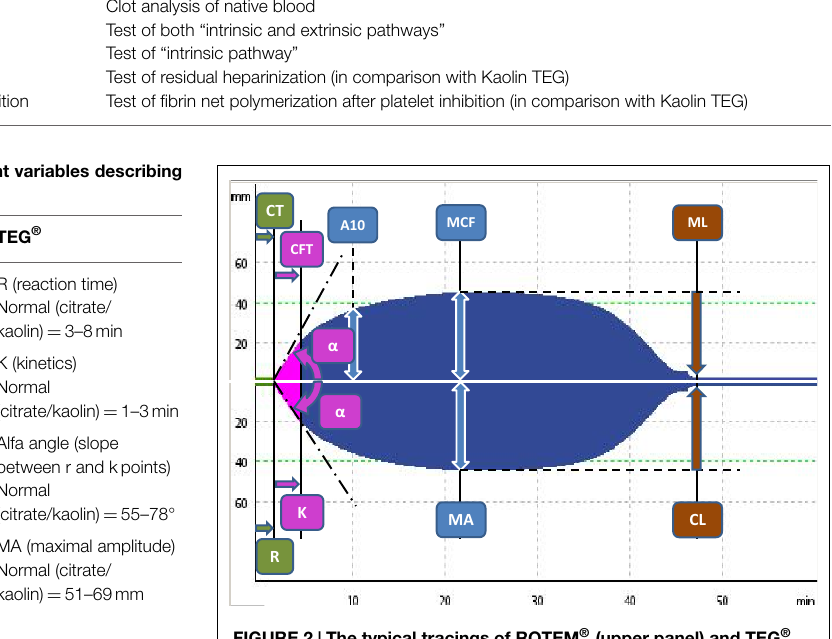
FIGURE 2 | The typical tracings of ROTEM ® (upper panel) and TEG ® devices (lower panel) with the most prominent parameters of both methods with the comparison (see also Table 2)